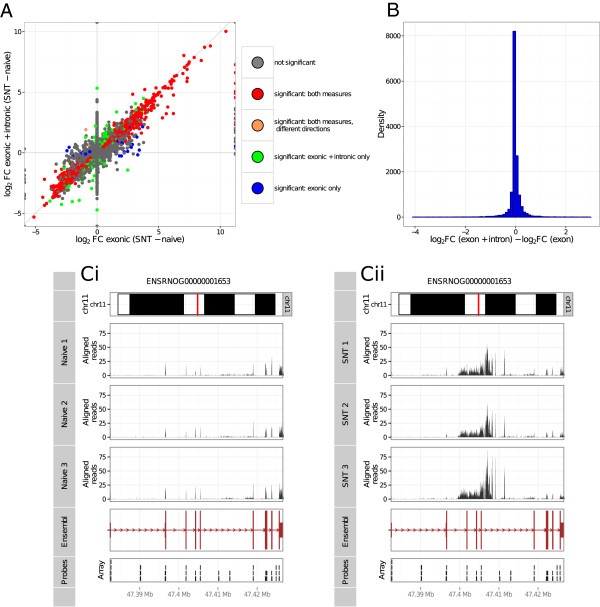
The effect of intronic expression on fold change calculation. A) Estimation of log2 FC considering exonic reads only (x-axis) compared to FC calculating counting exonic and intronic reads (y-axis). Red points represent genes called DE when using both counting schemes with the same direction of fold change, peach points represent the two genes that are called as DE with both schemes, but with opposite directions of fold change. Green points show genes called DE when considering exonic reads only, but not when considering exonic and intronic reads. Blue points show genes DE when considering exonic and intronic reads but not when considering exonic reads only. B) Distribution of the ratio of fold changes estimated by both methods. Calculated by subtracting the log2 FC values calculated using full gene expression from log2 FC calculated exon expression only. Ci, Cii) Genome graphs for gene St3gal6, showing intronic expression that is not proportional to exonic expression, i.e. that is increased following SNT. The figure comprises a series of “tracks” for each gene, and its expression levels for SNT samples (Ci) and naive samples (Cii). The top tracks show the genomic coordinates of the gene on chromosome 11 (precise position marked in red). The middle histogram-like tracks show the positions of RNA-seq reads mapping to the genomic location of the gene. Below these tracks is a track showing the gene structure (exons are represented by boxes, introns are represented by arrowed lines, the direction of these arrows shows the direction of transcription). Bottom track shows the position of the microarray probes that map to the genomic location of the gene.